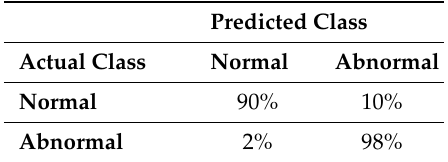
Table 5. Confusion matrix for detection (normal vs. abnormal) experiments.